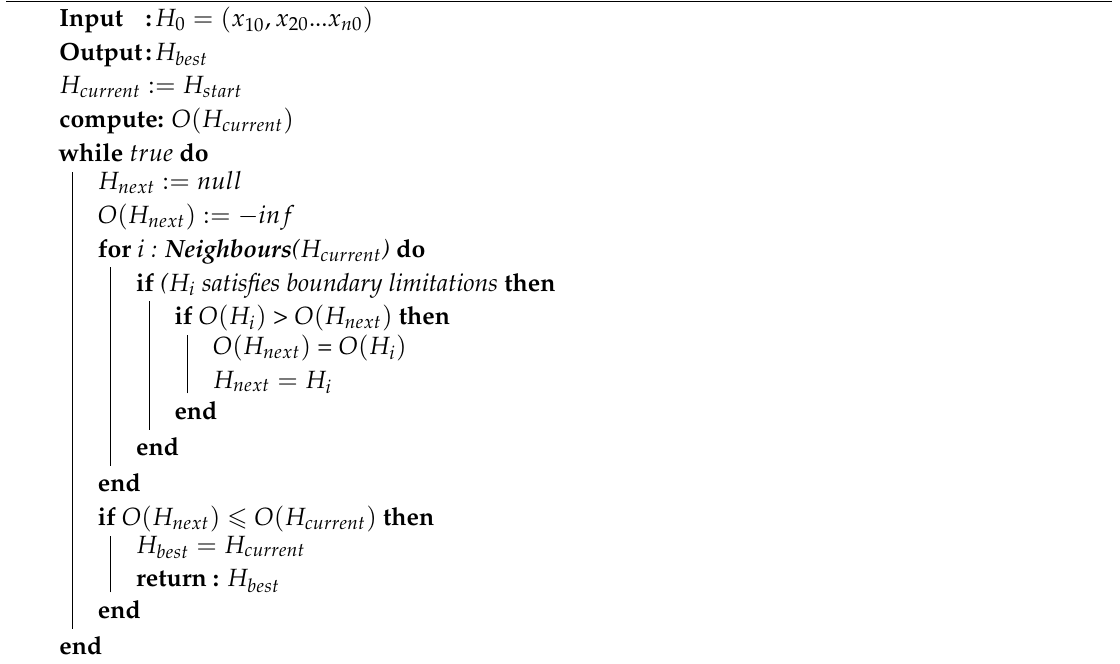
Algorithm 3: Generalized Hill-climbing Algorithm